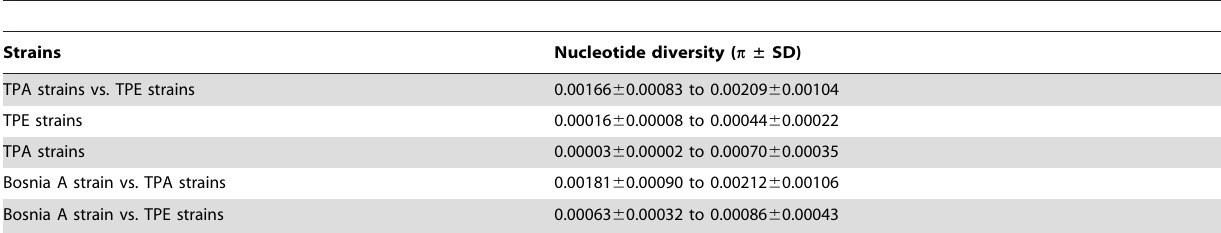
Table 4. Calculated nucleotide diversity ( p 6 standard deviation) between TPA and TPE strains, within individual TPE strains, within TPA strains, and between Bosnia A strain and TPA and TPE strains.